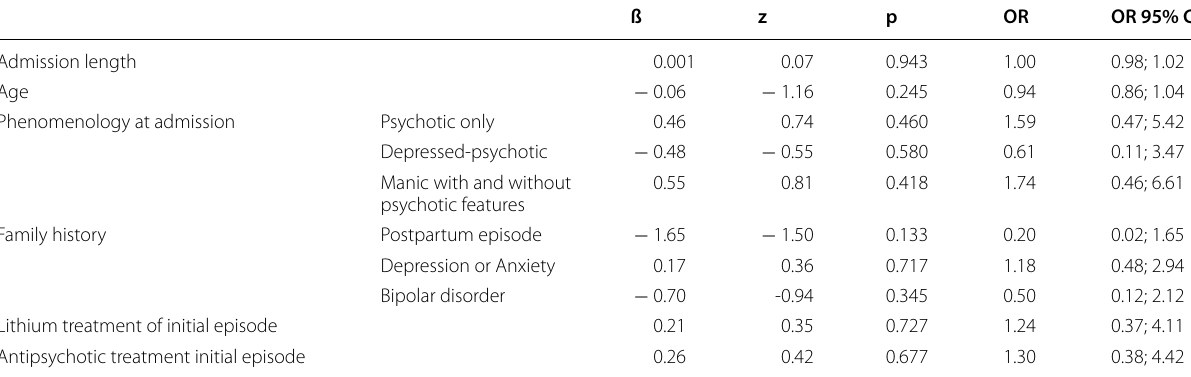
Table 2 Logistic regression analysis of the clinical predictors for recurrence of non‑postpartum mood or psychotic episodes within the follow‑up